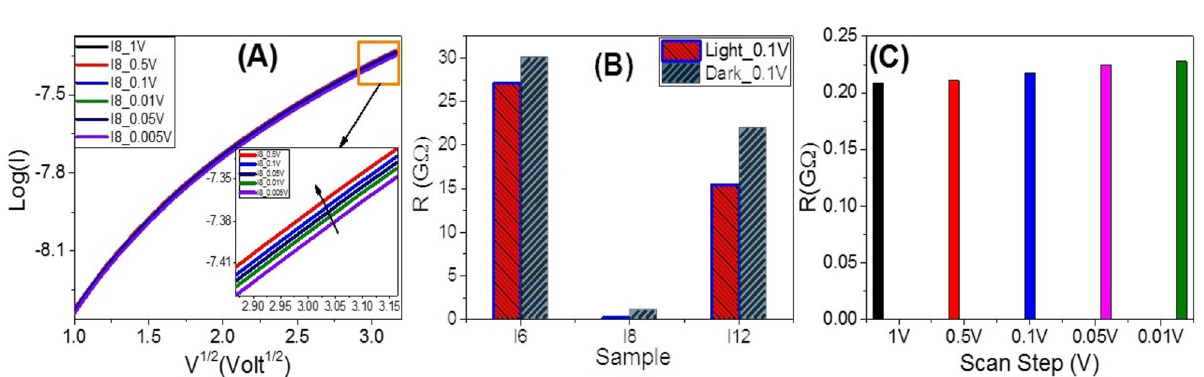
Figure 10. ( A ) Log(I) vs. V 0.5 For I-8 sample at different step scan; ( B ) effective electric resistance in dark and white light illumination conditions for I-6, I-8 , and I-12 samples in liquid crystal phase designed at 140 °C; and ( C ) effective electric resistance at different scan step for sample I-8